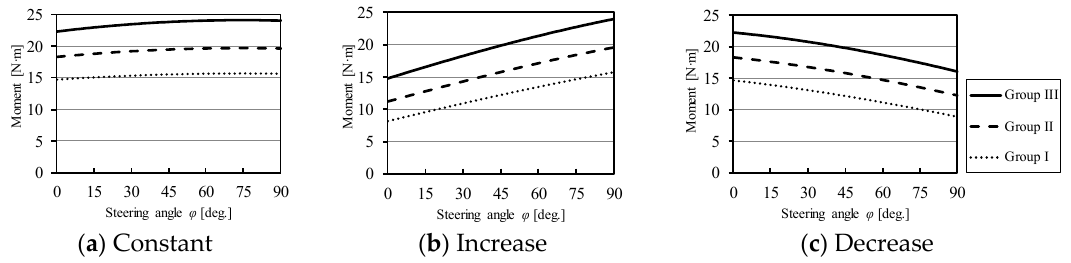
Figure 10. Relationship between steering angle and moment .